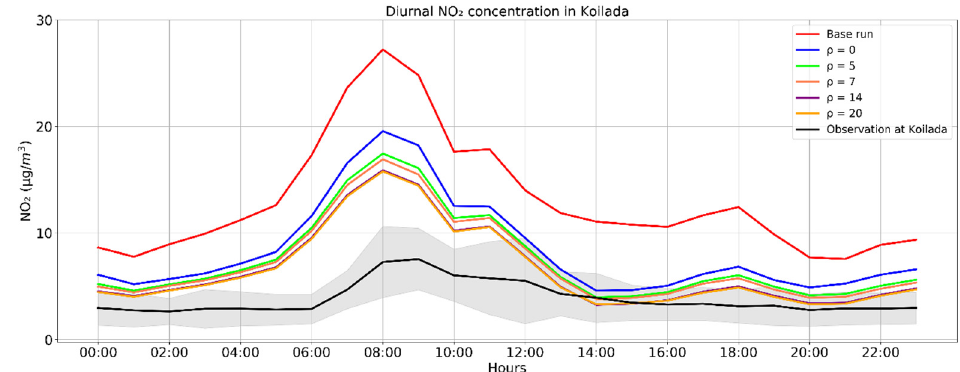
Figure A1. Diurnal cycle of the assimilated NO 2 simulations in July 2019 from the sensitivity tests using ρ values of 0, 5, 7, 14 and 20 km in the grid pixel where Koilada air quality station and Ag. Dimitrios power plant are located. The black line denotes the in situ measurement of Koilada station, with the associated standard deviation shown as a grey shaded area, while the red line the base run performed.